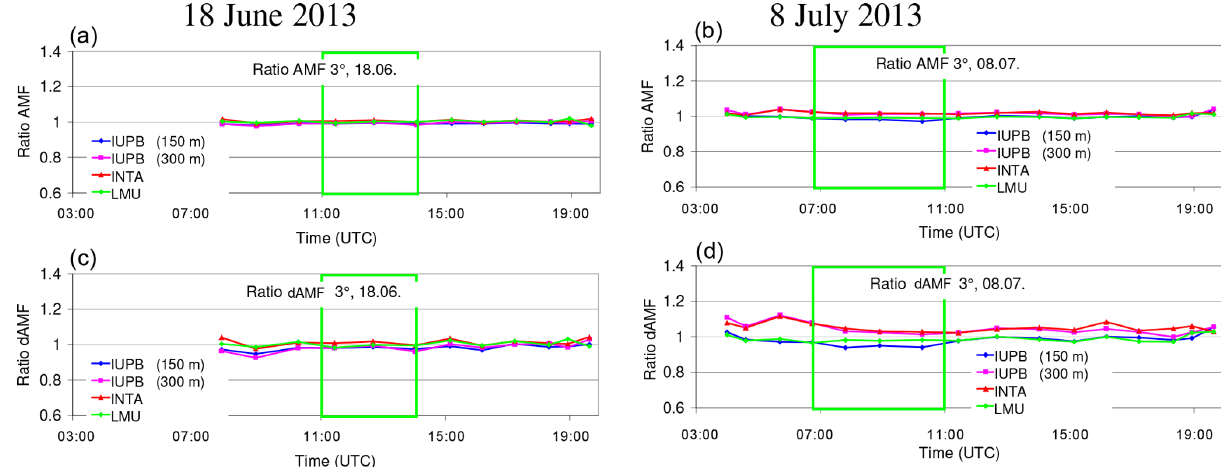
Figure A7. Ratios of the O 4 AMFs (a, b) and O 4 dAMFs (c, d) derived for aerosol extinction profiles extracted by different groups vs. those for the standard aerosol extinction profiles (MPIC) for both selected days.